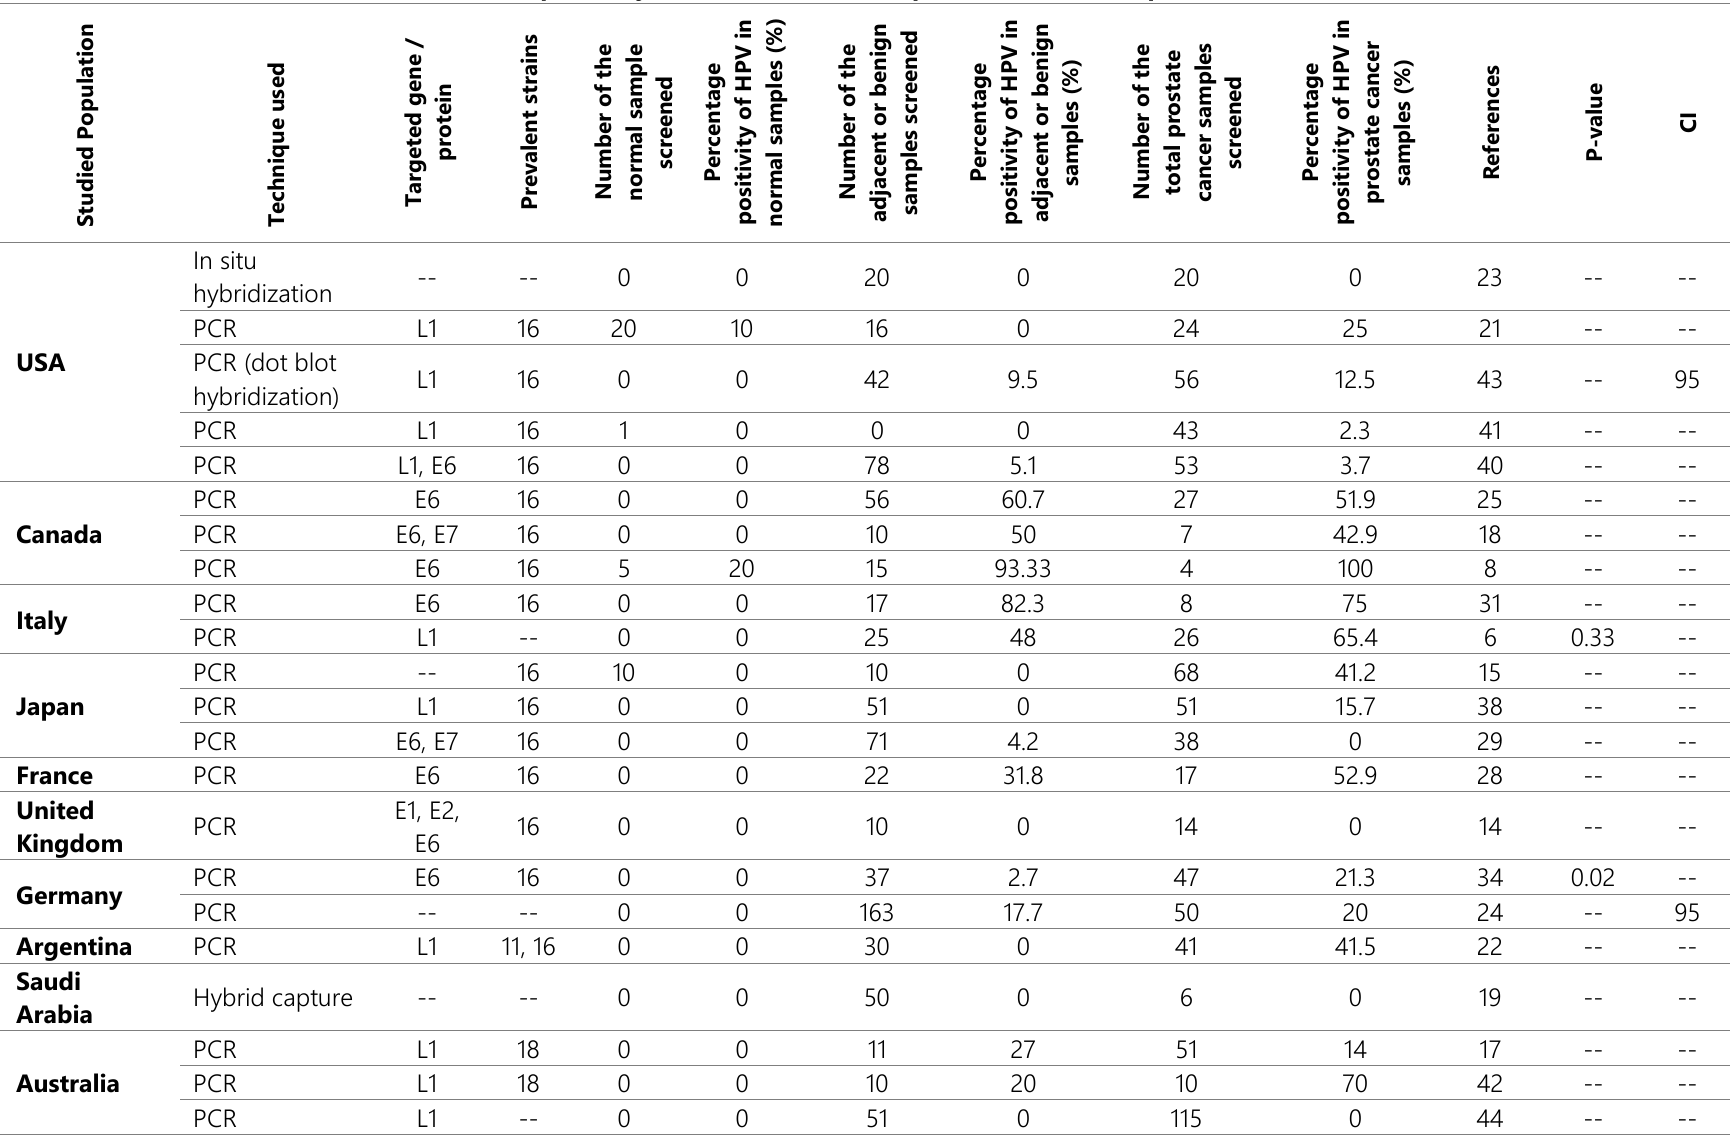
Table 1: Information of the HPV positivity ratios in controls and prostate cancer samples relative to the selected articles